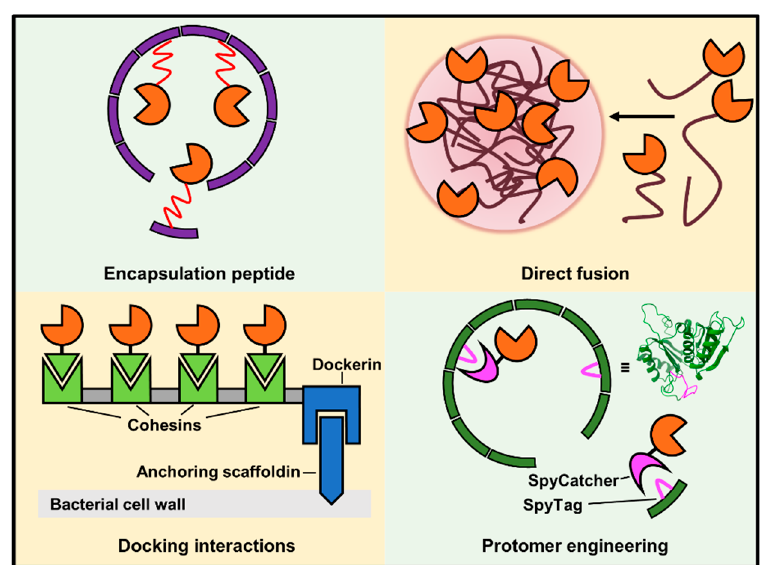
Figure 3. Examples of various methodologies for loading cargo (depicted by the orange circle with a missing slice) onto protein shells and scaffolds. Installation of a suitable encapsulation peptide sequence (red wavy line) on the cargo can direct the cargo into a shell (e.g., encapsulins, BMCs) [51,52]. Cargo can be translationally fused to a protein subunit of a compartment to direct encapsulation (e.g., MO) [36]. Use of docking/protein–protein interaction domains can direct cargo to the scaffold (e.g., cellulosome) [53]. The protomer of a shell can be engineered to present protein conjugation domains, such as SpyCatcher with SpyTag [54].